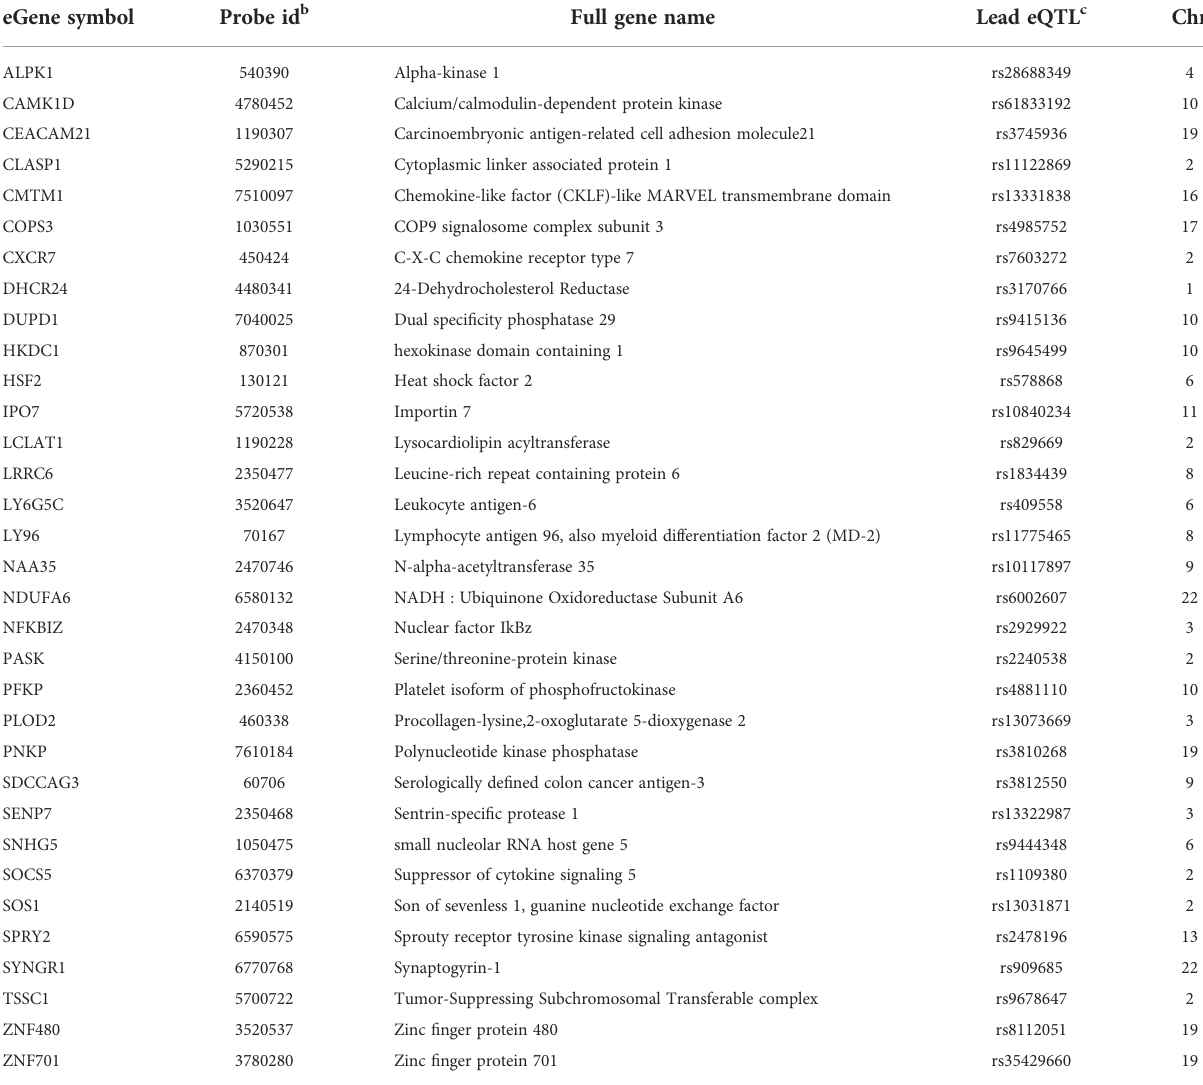
TABLE 3 eGenes with increased expression in women with endometrial infection, and their corresponding cis-eQTLs and chromosomal locations (mediation test FDR a <0.2). eGene